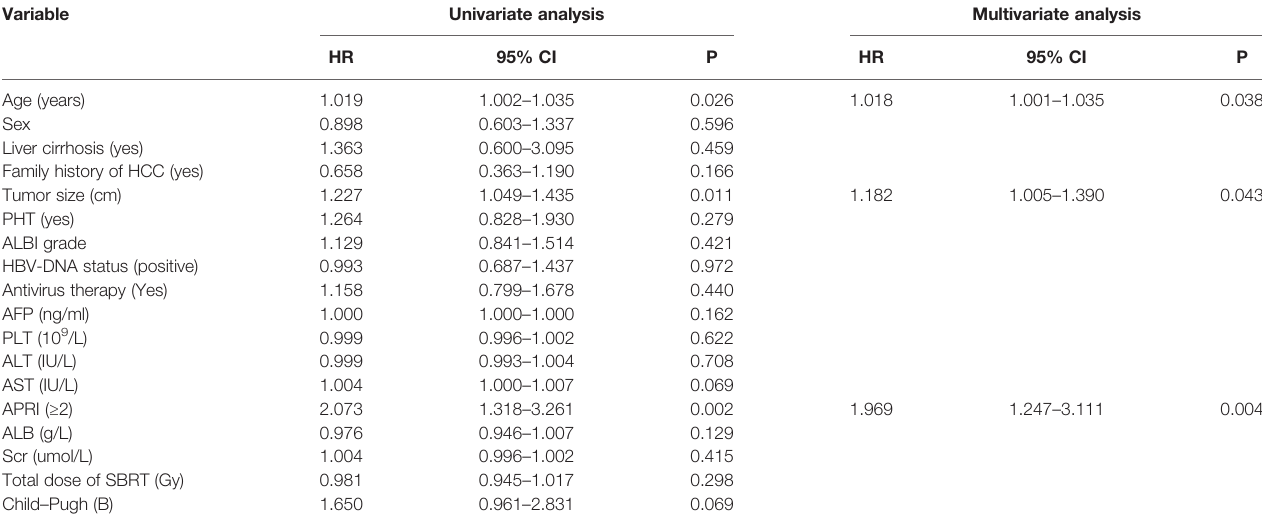
TABLE 3 | Risk factors for Recurrence: Univariate and multivariate Cox regression analyses.